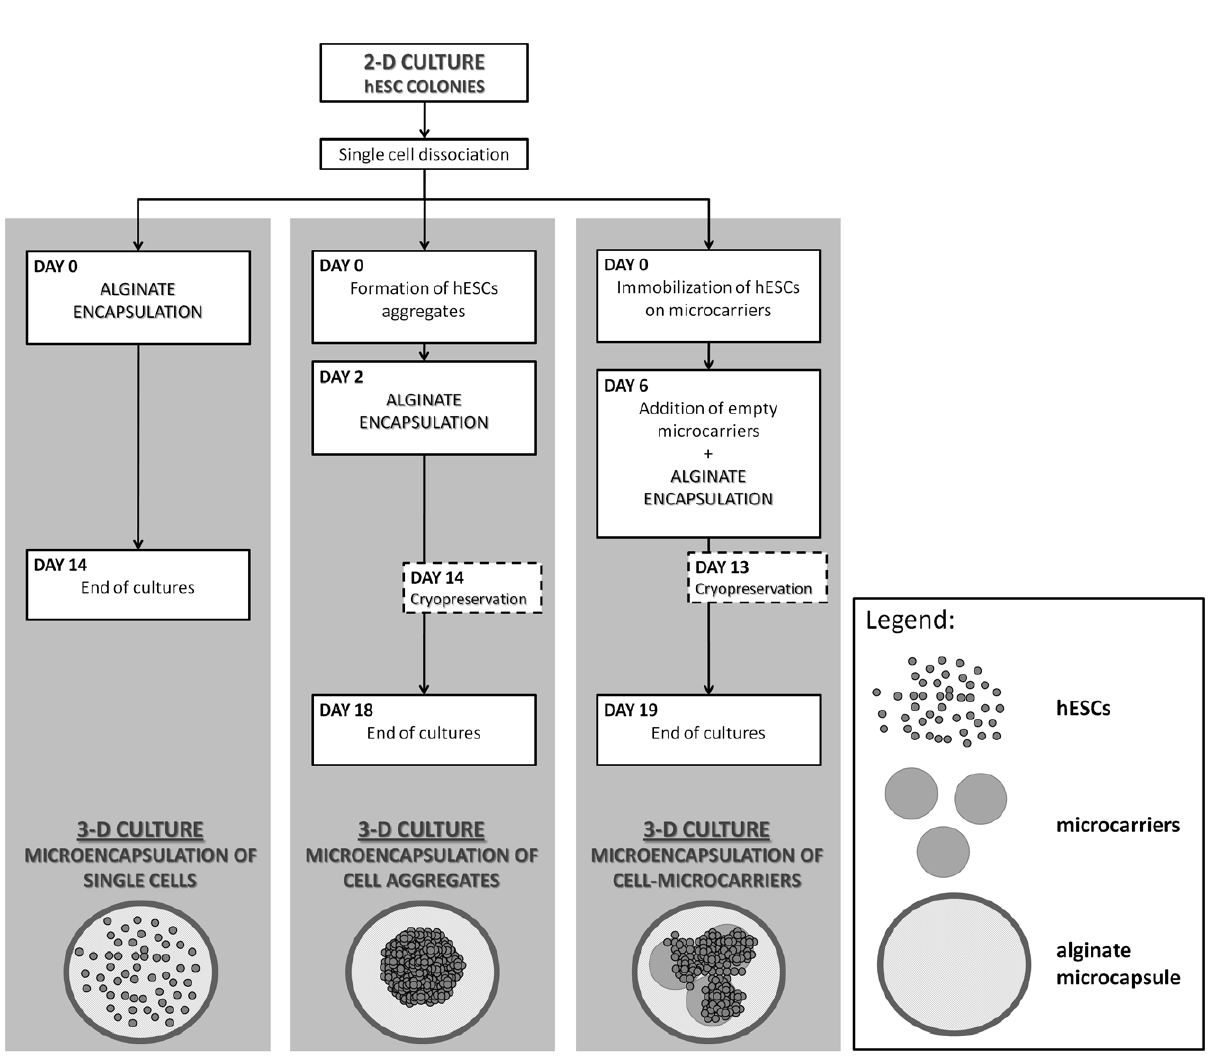
Figure 1. Main steps of the microencapsulated 3D culture strategies developed for expansion and cryopreservation of hESCs.